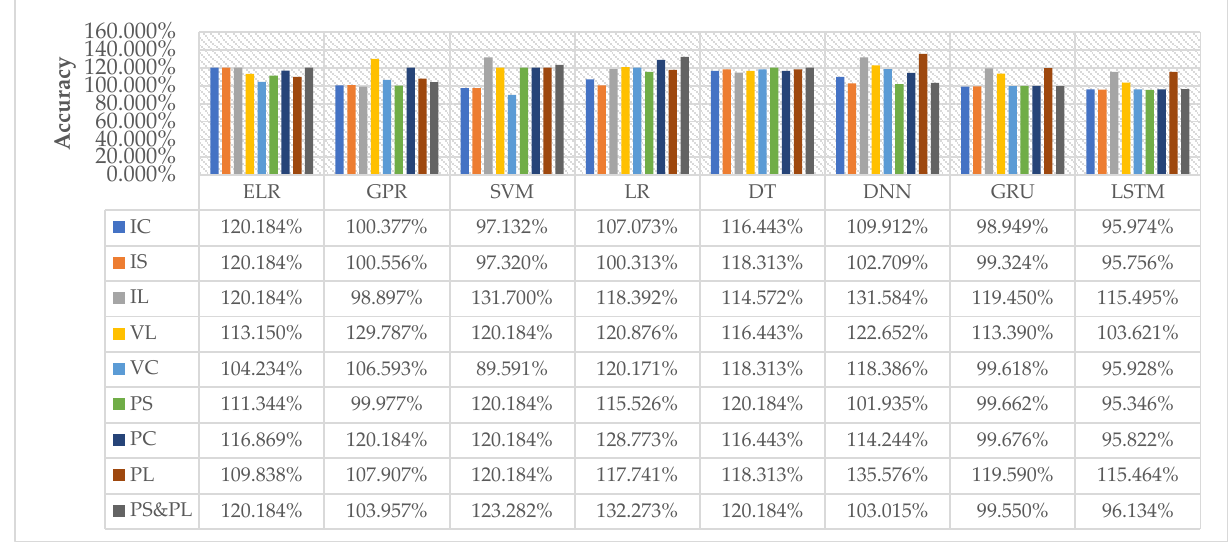
Figure 13. Average accuracy of the estimated capacitance using discrete wavelet transform (DWT) analysis .